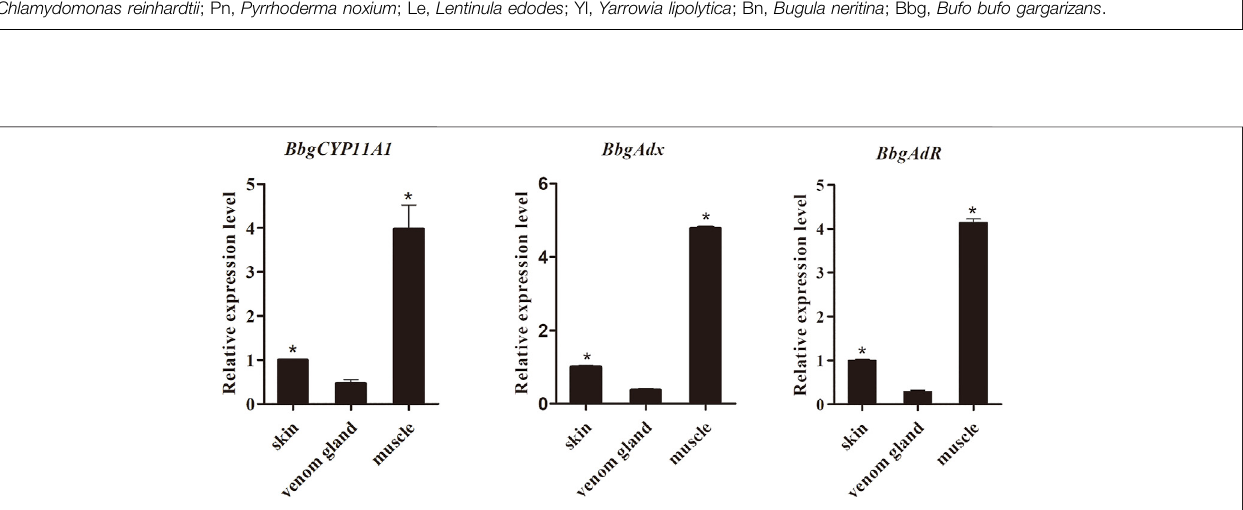
Frontiers in Genetics |